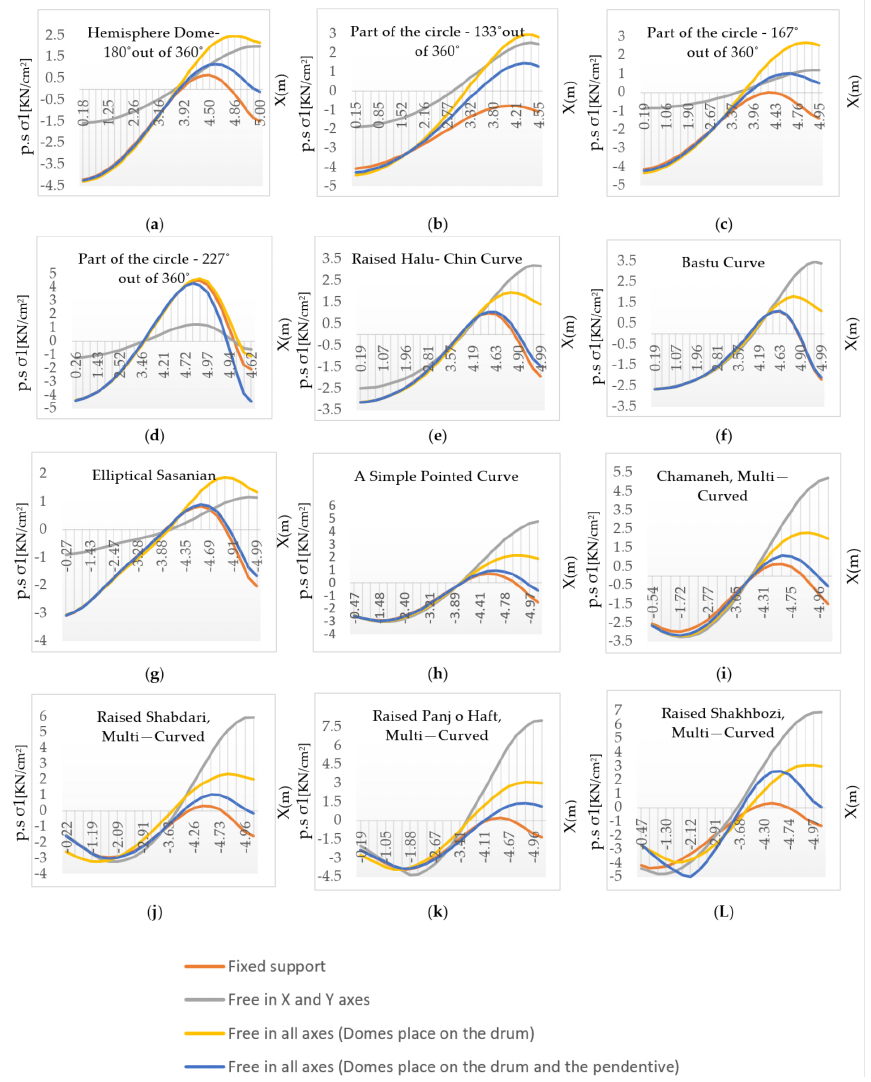
Figure 5. Position of neutral hoops on domes. R m = 5 m, t dome = 90 cm, t dome /d m = 0.09, H drum = 3 m, t drum = 90 cm, R drum = 5 m, R drum with pendentive = 6 m. ( a ) p.s σ 1 of hemispherical dome—180 ◦ out of 360 ◦ ; ( b ) p.s σ 1 of part of the circle curve—133 ◦ out of 360 ◦ ; ( c ) p.s σ 1 of part of the circle curve—167 ◦ out of 360 ◦ ; ( d ) p.s σ 1 of part of the circle curve—227 ◦ out of 360 ◦ ; ( e ) p.s σ 1 of raised Halu-Chin curve; ( f ) p.s σ 1 of Bastu curve; ( g ) p.s σ 1 of Elliptical Sasanian curve; ( h ) p.s σ 1 of a simple pointed curve; ( i ) p.s σ 1 of Chamaneh, Multi—Curved; ( j ) p.s σ 1 of Raised Shabdari, Multi—Curved; ( k ) p.s σ 1 of raised Panj o haft, Multi—Curved, ( l ) p.s σ 1 of raised Shakhbozi,